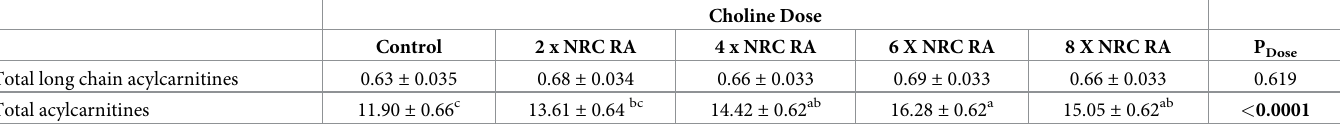
C18:0 as compared to 2 x NRC RA. Similarly, choline at an intake of 6 x NRC RA resulted in greater serum concentrations of LPC C18:1, when compared to 2 x NRC RA and control